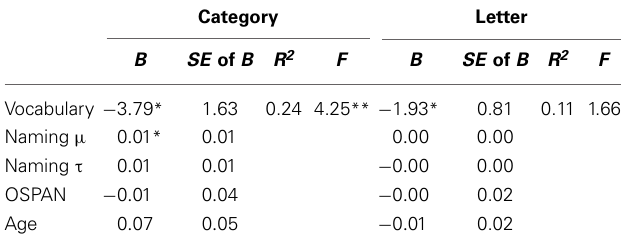
Table 5 | Results of the multiple regression analysis with 1st response time (RT) of category and letter fluency tasks as criterion variables and vocabulary knowledge, ex-Gaussian parameter µ and τ of naming RT, operations span (OSPAN), and age as predictor variables.